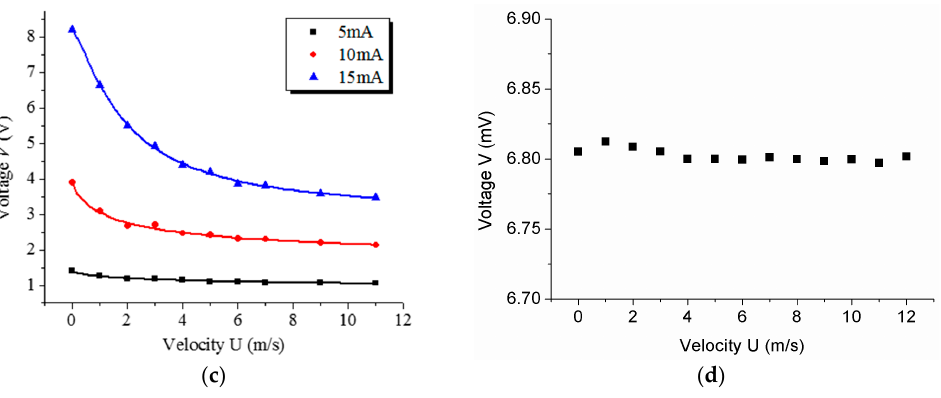
Figure 4. ( a – c ) Output voltages and fittings of two DWCNT anemometers under diversified air velocity with different driving currents; ( a ) sensor N1: 6 mA, fitted exponent n = 1.23; ( b ) sensor N1: 1 mA, fitted exponent n = 0.82; ( c ) sensor N2: 5 mA ( n = 0.70), 10 mA ( n = 0.77) and 15 mA ( n = 1.29); ( d )